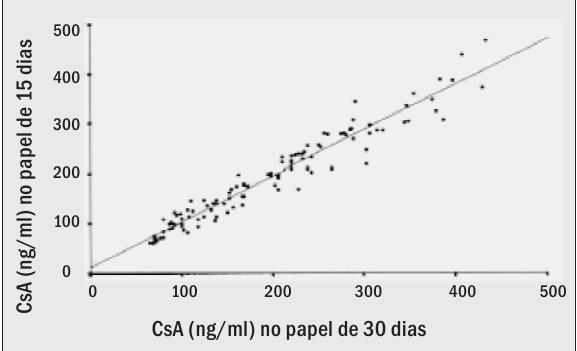
Figura 3 – Correlação linear entre as amostras de papel de 15 e 30 dias ( r = 0,968; p <